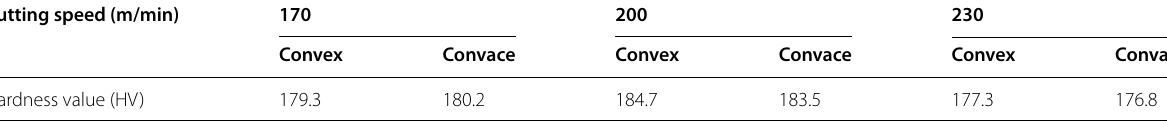
Table 8 Microhardness variation of machined surfaces with feed rate Feed rate (mm/r) 0.1 0.2 Convex Convace Hardness value (HV)